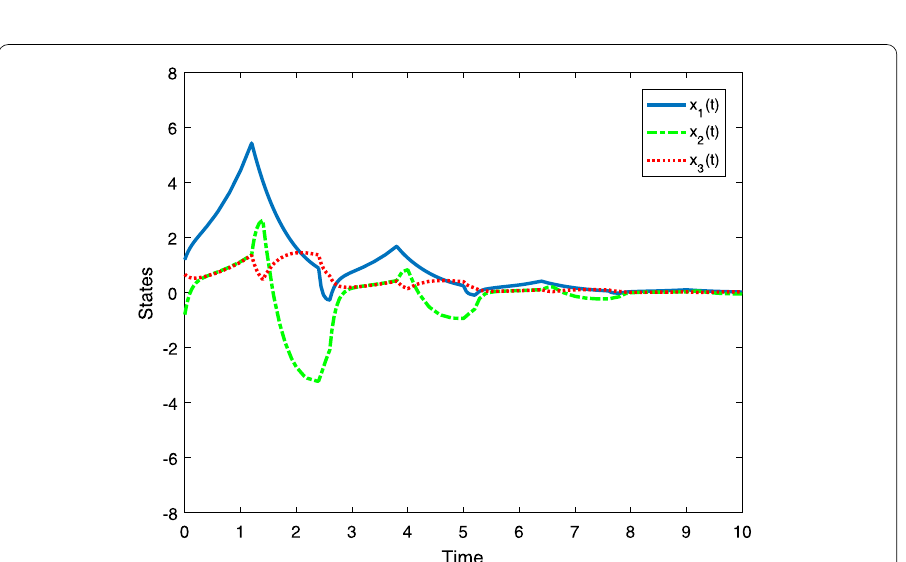
Figure 1 The switching signal